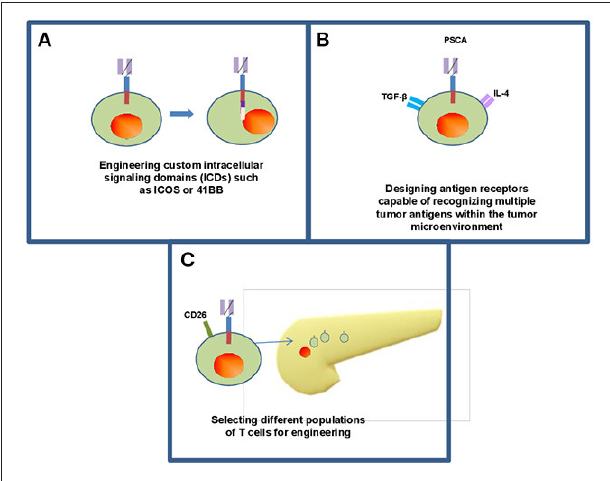
FIGURE 3 | Frontiers in CAR T cell therapy for pancreatic ductal adenocarcinoma. Continuing research within CAR T cell therapy for solid organ malignancy has opened new methods for engineering T cells including enhancing intracellular signaling domains (A) to enhance persistence of CAR T cells within the body as well as efficacy against tumors. (B) Some groups have designed CARs that recognize multiple antigens within the tumor microenvironment while maintaining their antitumor activity within the body (42). (C) There is opportunity to utilize individual phenotypically defined populations of T cells including CD26 high cells